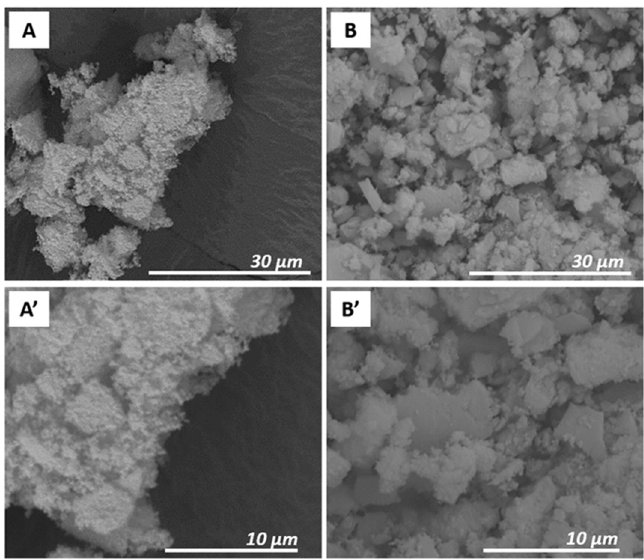
Figure 6. SEM images of PB_Syn ( A , A’ ) and PB_Acid ( B , B’ ) at 5000× and 10,000×